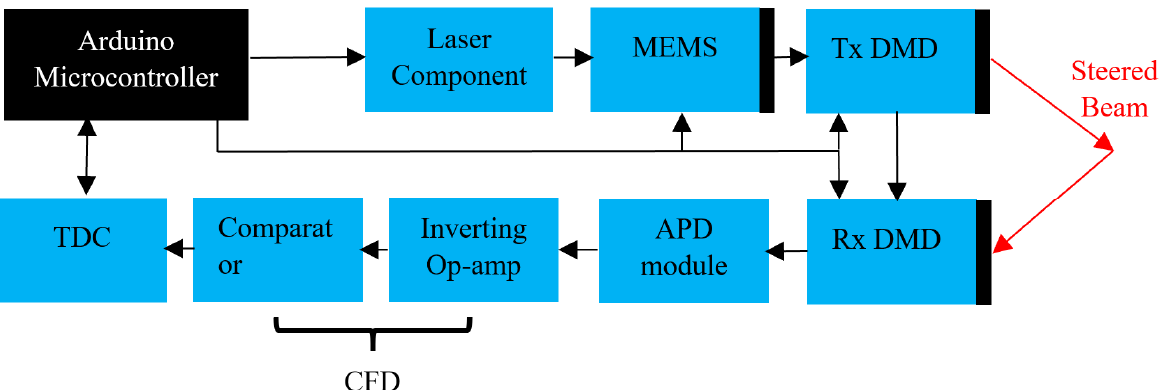
Figure 6. Block diagram of the system operation with time-of-flight (ToF) circuitry. The microcon- troller triggered the laser, Tx- and Rx-DMD, and 2D-MEMS mirror. For each of the laser pulses, the ToF measurement was employed.